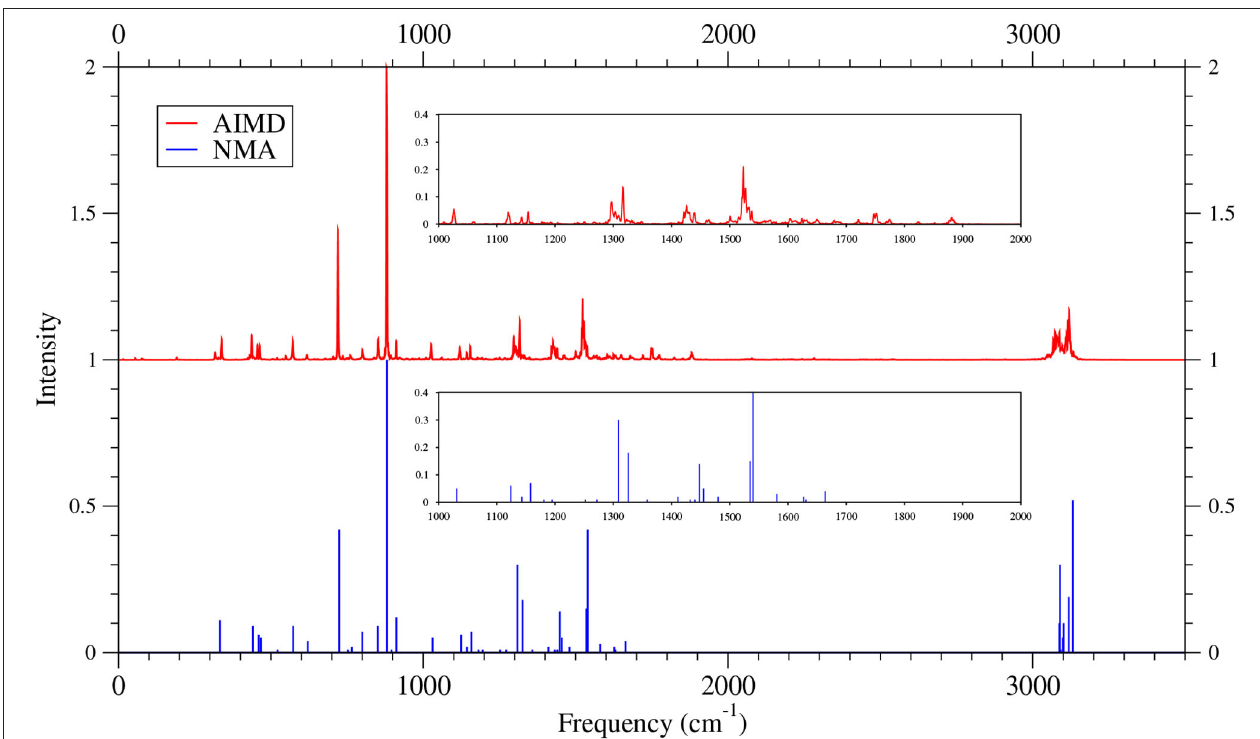
FIGURE 12 | IR spectra of 8-acene, obtained with the TAO-AIMD simulations at 300 K and GS-NMA, calculated by TAO-LDA. The IR spectra are normalized to have a maximum intensity of one and, for clarity, are vertically offset from each other by the same value. Subfigures show the IR spectra in the 1,000–2,000 cm − 1